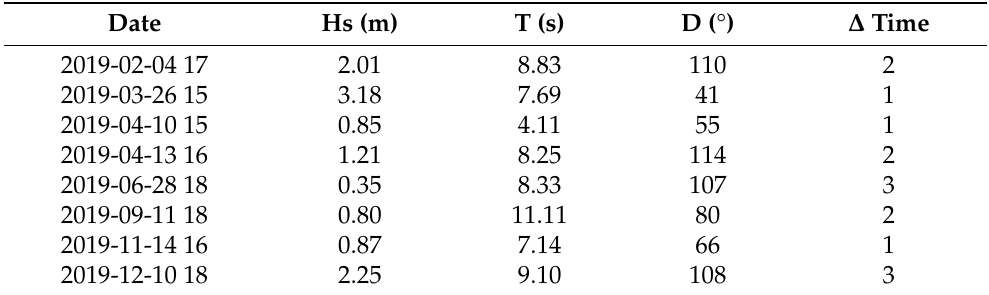
Table 2. The significant wave height, peak period, and peak direction for each date shown in Figures 4 and 5 as well as the time difference between the image and the survey time in